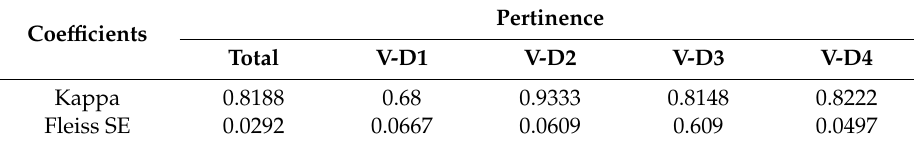
Table 3. Cohen’s Kappa values for inter-rater variability on the scale of Pertinence. Coe ffi